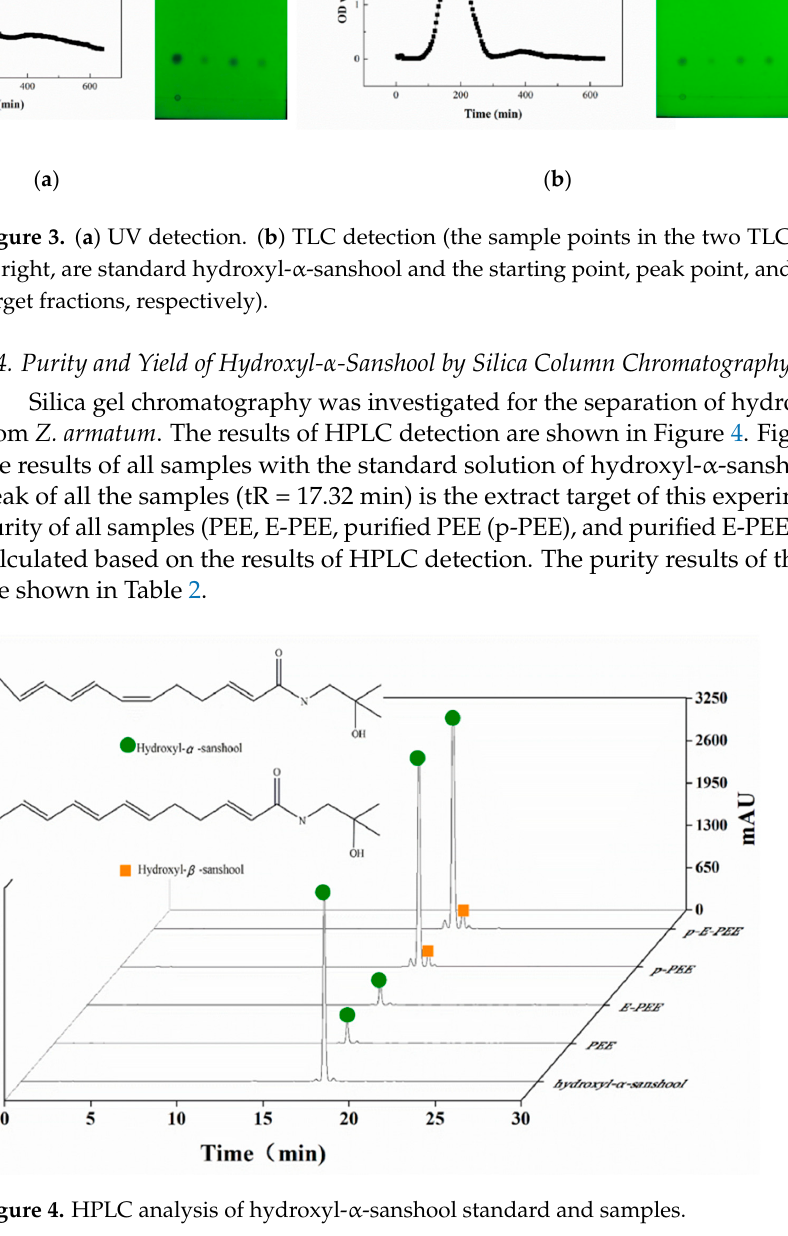
target fractions, respectively).